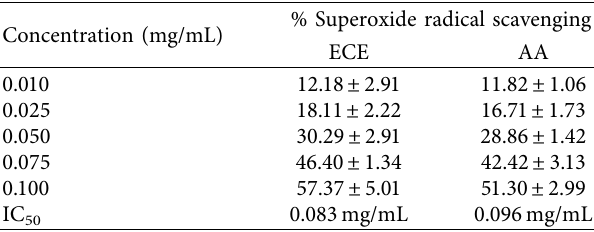
Table 3: Superoxide radical scavenging activity of E. californicum extract (ECE) and ascorbic acid (AA).